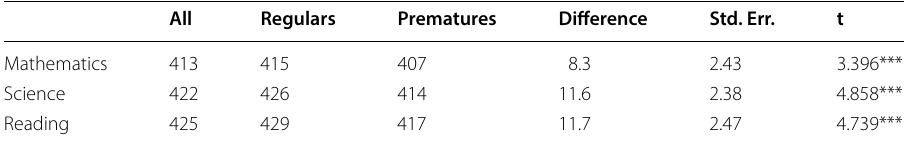
Table 4 Probability of repeating a year, PISA scores, and mean differences by age of entry Source: Own estimations with data from PISA